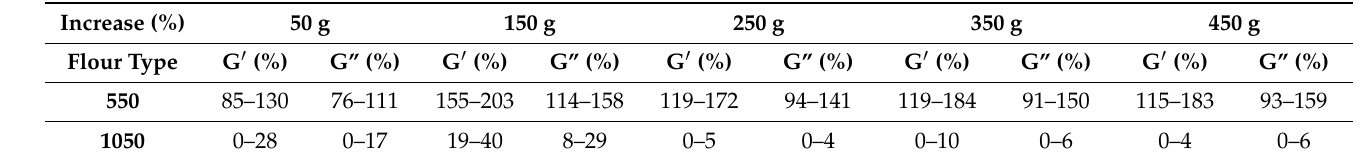
Figure 8. Change in the storage (G ′ ) and loss (G ′′ ) moduli of wheat dough as a function of NTP treatment at different reactor fillings (50, 150, 250, 350 and 450g, at 10 RPM): ( a ) type 550; ( b ) type 1050. Table 2. Increase in the G ′ and G ′′ values of the doughs produced with plasma-treated flour samples (presented as minimum-to-maximum increase in comparison to doughs produced with untreated flour samples) as a function of reactor filling (i.e., flour mass).